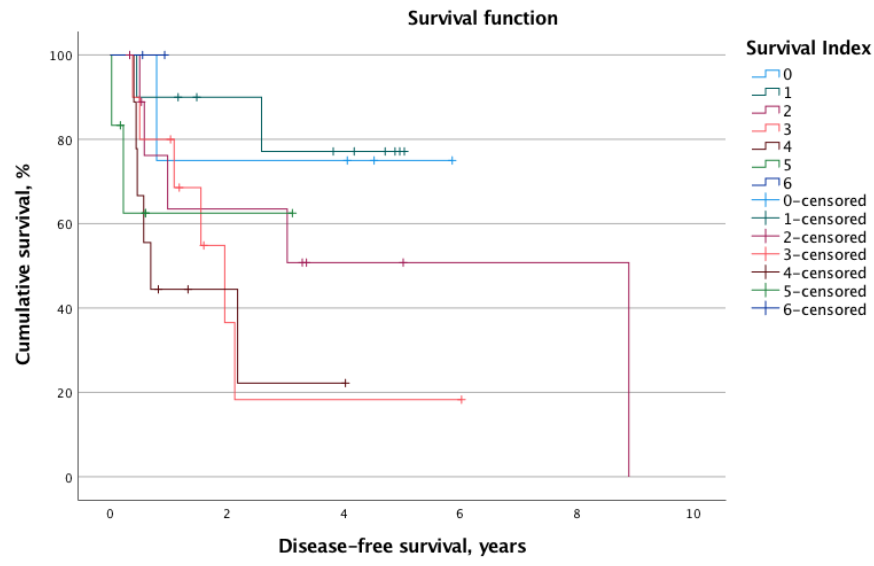
Figure 4. Similar to overall survival, the rising specific survival index score (0–6) was associated with worse disease-free survival. However, the correlation did not reach the level of statistical significance ( p = 0.161).